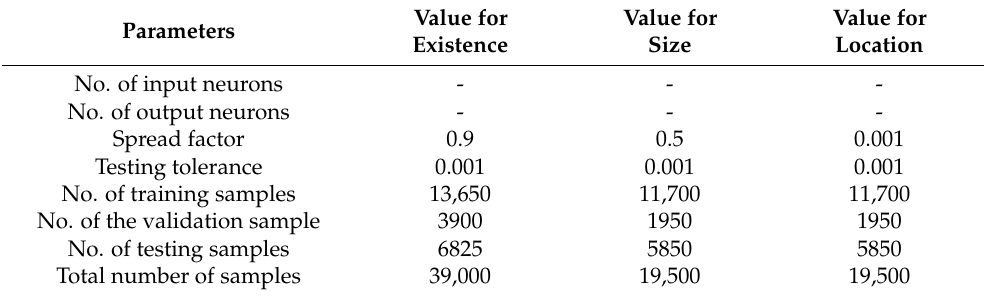
Table 4. PNN architecture is used in this